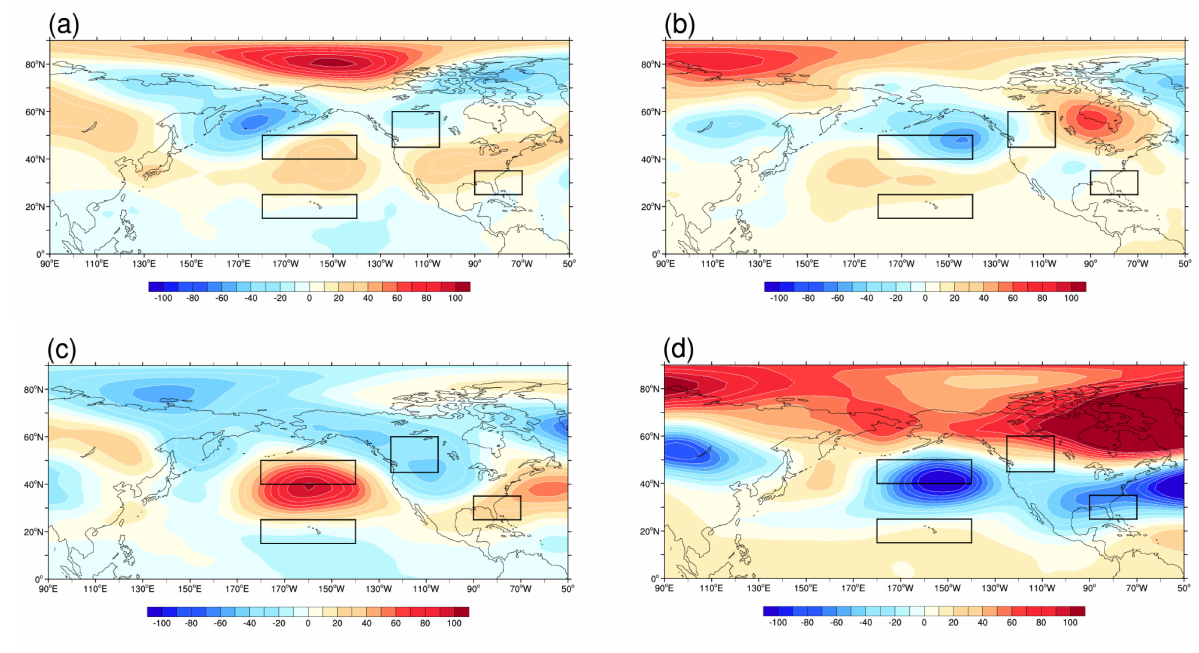
Figure 11. Distribution of geopotential height anomalies (gpm) at 500 hPa for ( a ) the autumn of 2007; ( b ) the autumn of 2009; ( c ) the winter of 2007–2008; and ( d ) the winter of 2009–2010. According to the quasi-geostrophic equation of motion, the change of the 200 hPa geopotential height anomaly field means that the Pacific Jet was also changed. The Pacific Jet in the winter of 2007/08 shifted north, while the Pacific Jet in the winter of 2009/10 shifted south (see Figure 12). This implies the North Pacific regional center is affected because the AO/NAM is the reflection of the zonal wind [4].